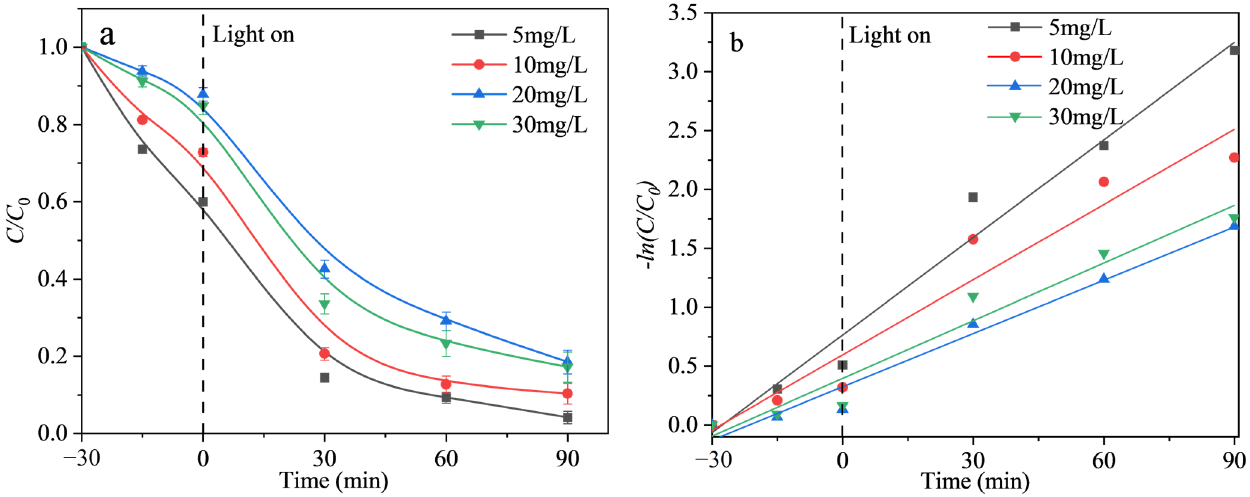
Figure 7. Effect of initial TCH concentrations on photocatalytic efficiency ( a ) and degradation reaction kinetics ( b ) (3 replicates; dosage of BiFeO 3 /BC = 0.05 g; pH = 4).